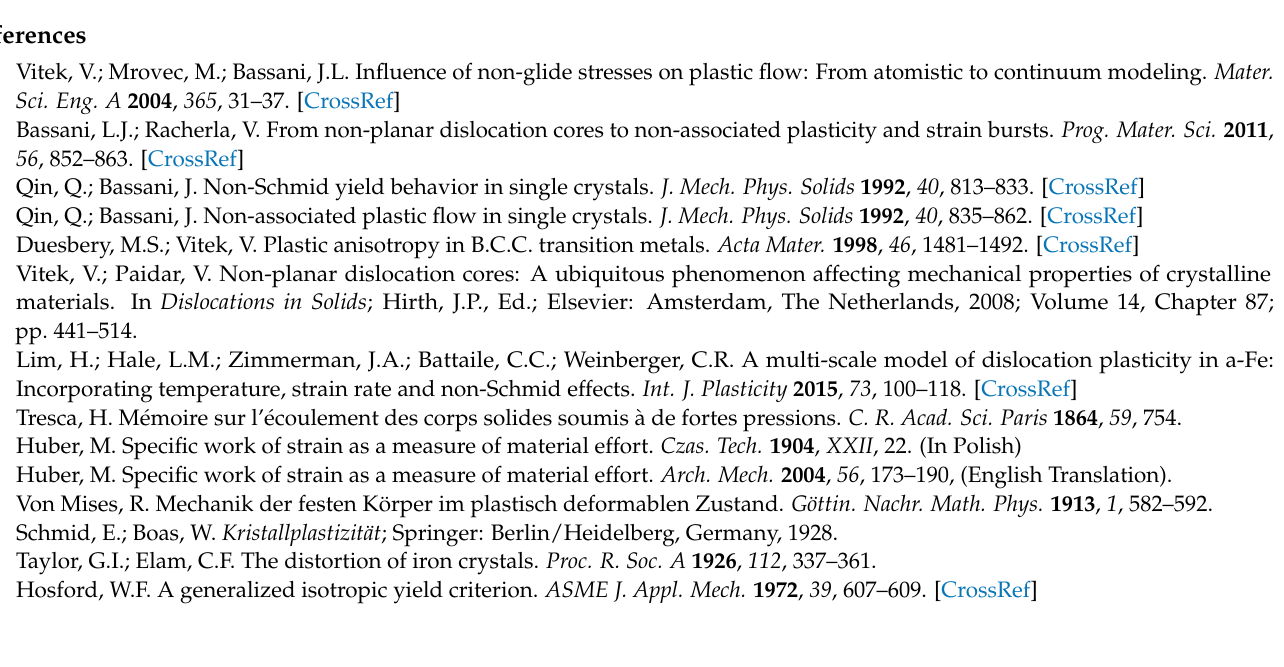
Figure A1. Yield surfaces are plotted for a non-shocked metal (black lines) and for the same metal at high shock pressure and the subsequent pressure relief (red line).